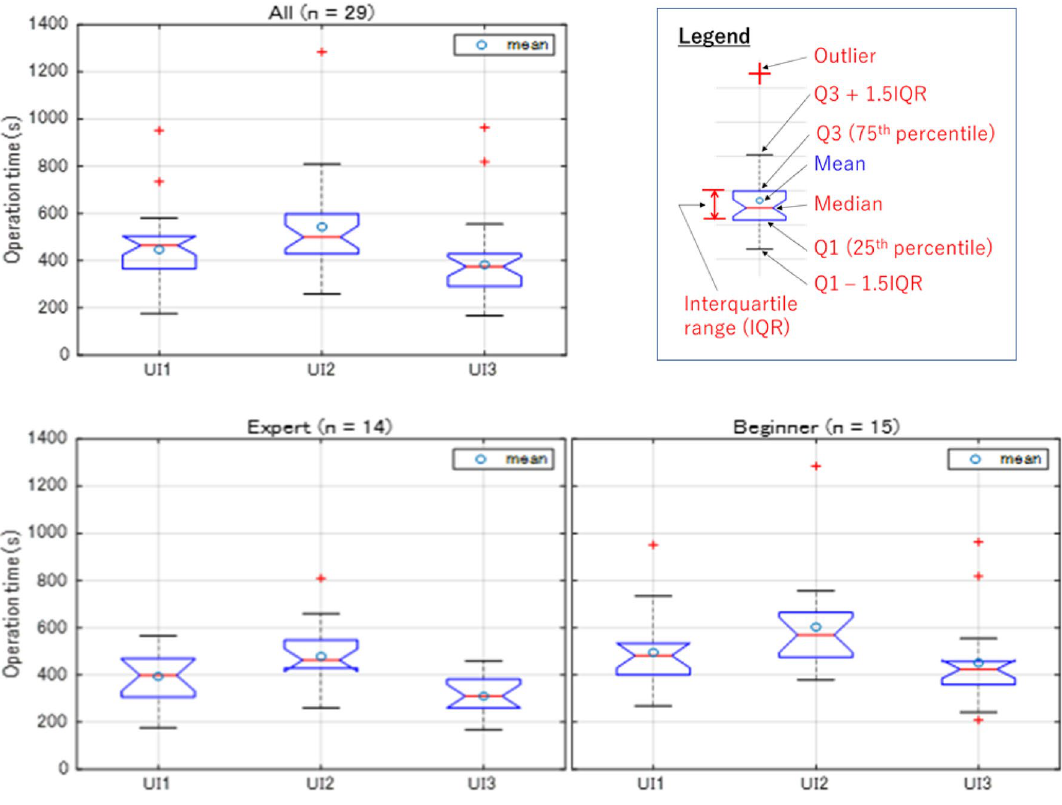
Figure 11. Operation time of each